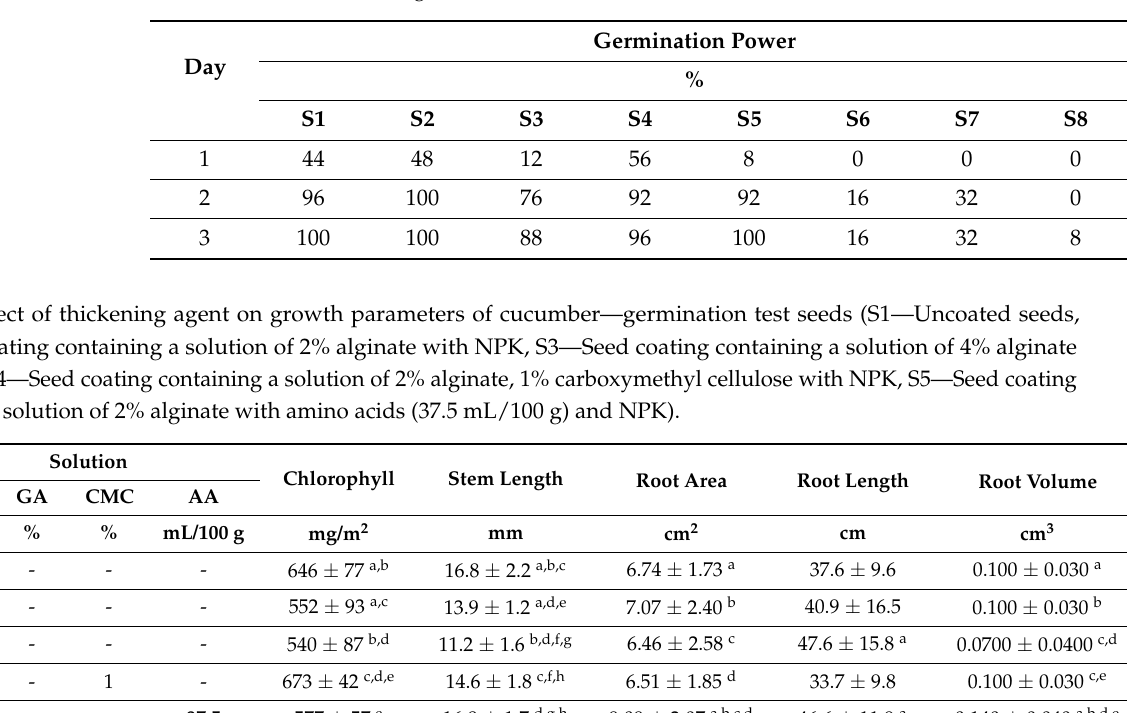
Table 4. Germination power of coated seeds (S1—Uncoated seeds, S2—Seed coating containing a solution of 2% alginate with NPK, S3—Seed coating containing a solution of 4% alginate with NPK, S4—Seed coating containing a solution of 2% alginate, 1% carboxymethyl cellulose with NPK, S5—Seed coating containing a solution of 2% alginate with amino acids (37.5 mL/100 g) and NPK, S6—Seed coating containing a 2% solution of gum arabic with NPK, S7—Seed coating containing a solution of 4% gum arabic with NPK, S8—Seed coating containing a solution of 4% gum arabic with amino acids (37.5 mL/100 g) and NPK).